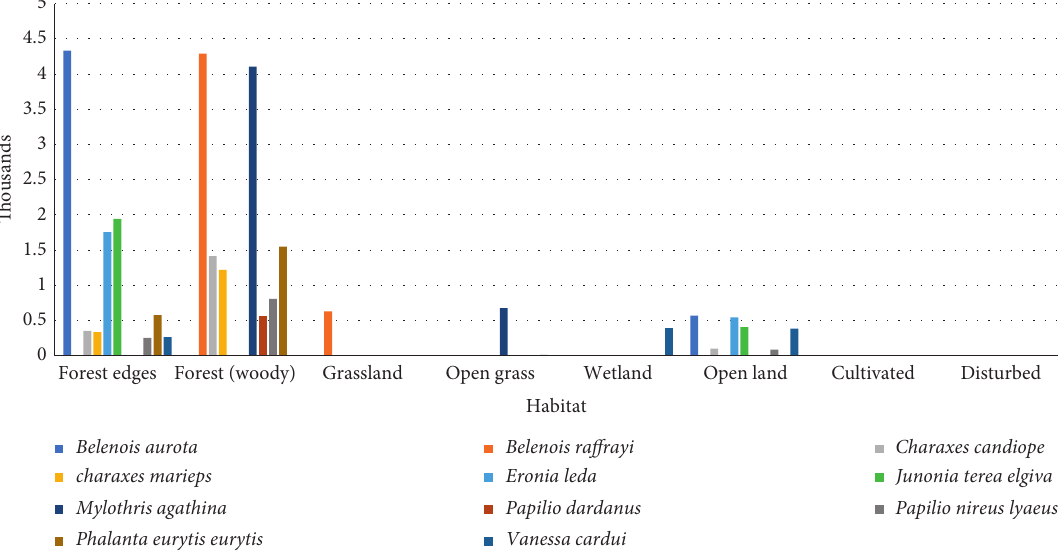
Figure 5: Abundance of butterfly species in different habitats of northwest Ethiopia, particularly in the three study